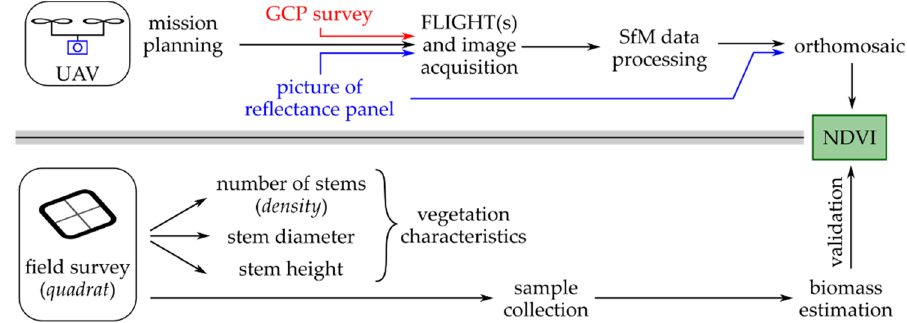
Figure 3. Flow chart of the field and photogrammetry analysis and validation.